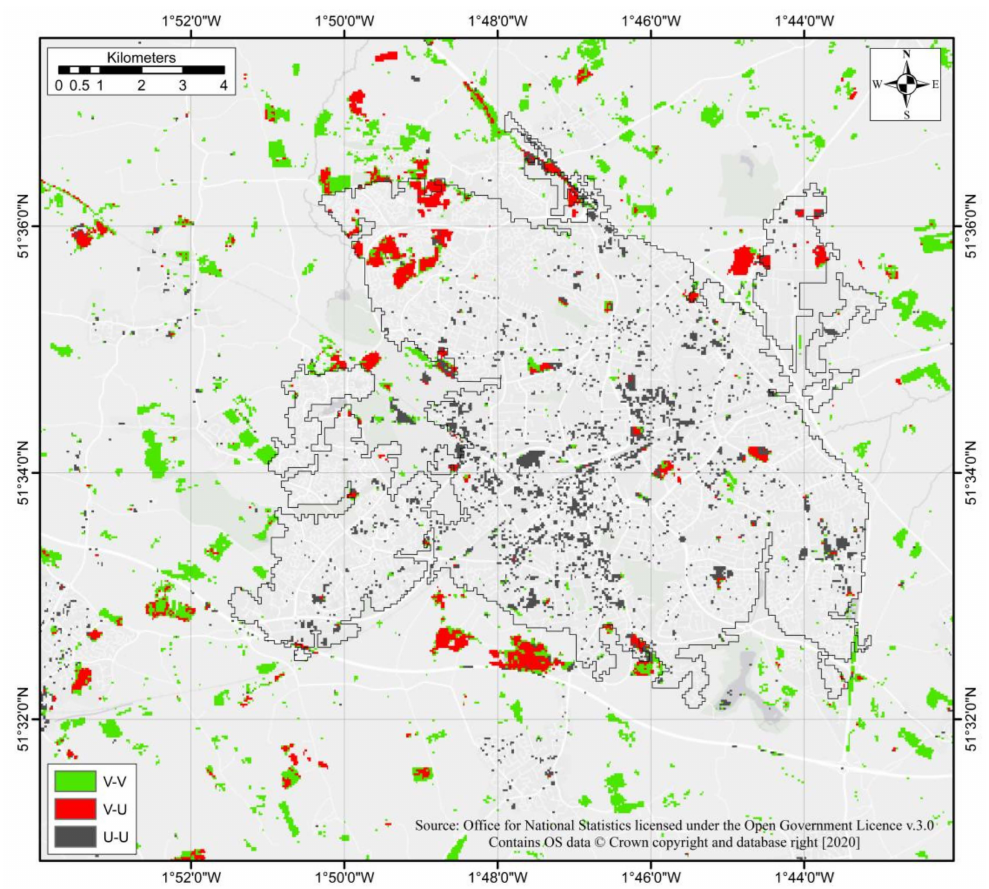
Figure 9. Classified change map produced using a random forest classifier. Grey line represents urban extent as of 2015 and may be used to qualitatively assign urban change to edge expansion, infill, and leapfrog type